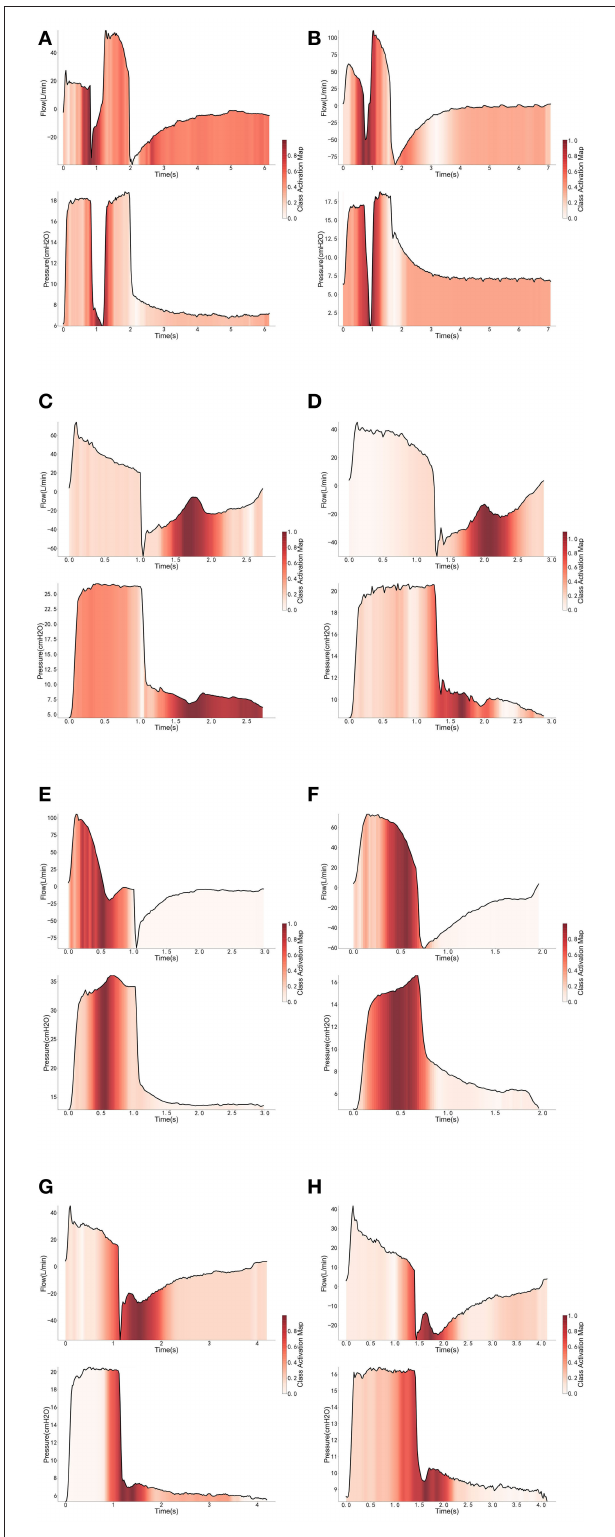
FIGURE 1 | Interpretation of the cycles classified as PVA under PCV mode (A,C,E,G) and PSV mode (B,D,F,H)